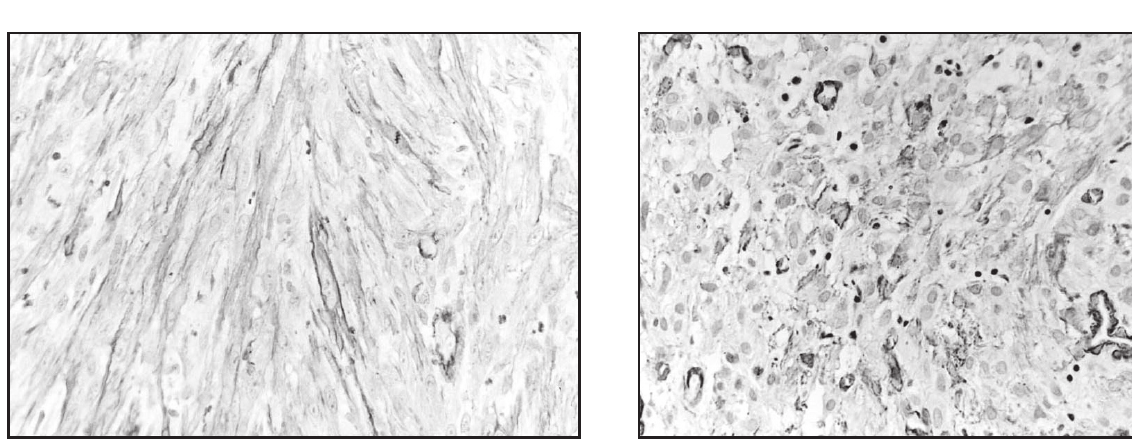
Figura 10 – Caso 2/AML. Todas as células neoplásicas exibindo marcação fortemente positiva para o anticorpo